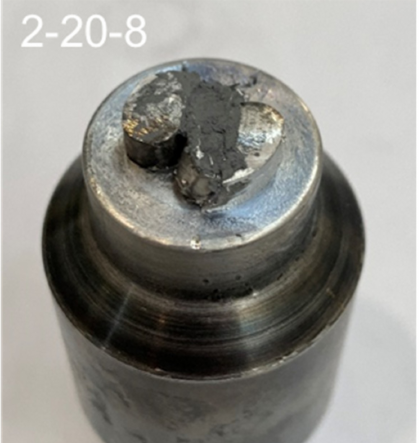
Figure 8. Centre cut prepared with tungsten carbide.